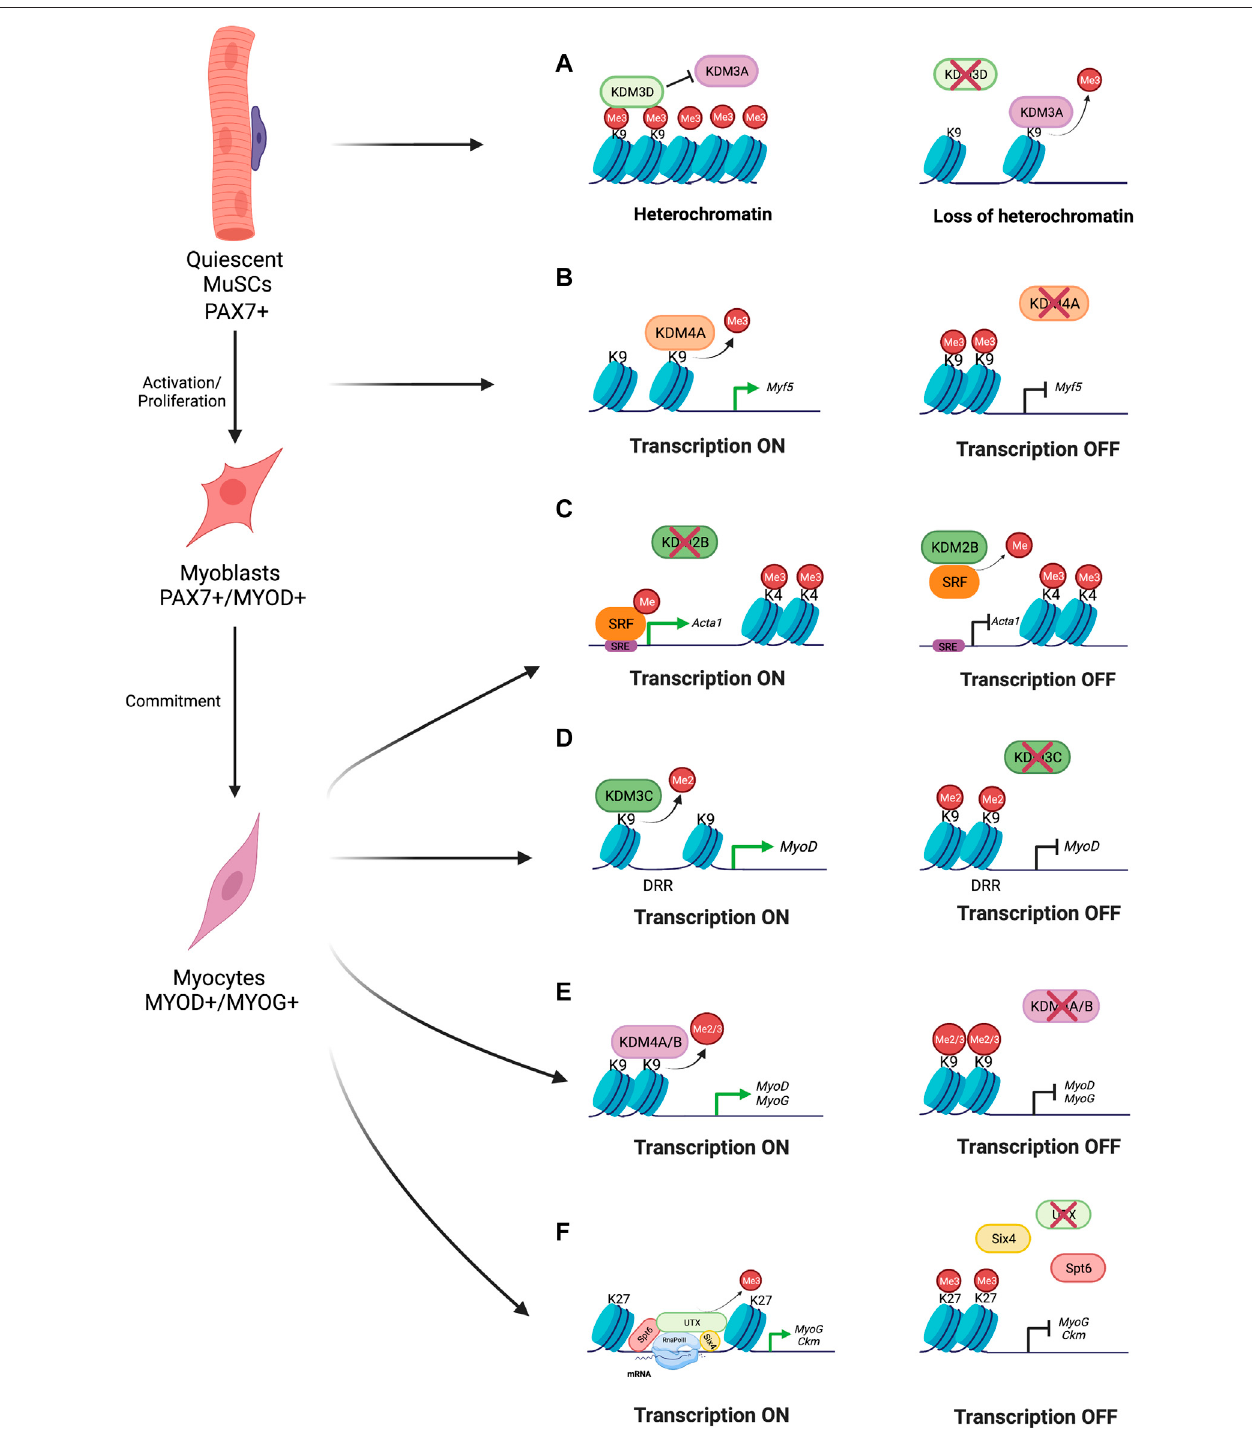
FIGURE 2 | Jumonji C-domain Demethylases Role during Skeletal Muscle Regeneration. (A) In order to maintain MuSCs quiescence, KDM3D inhibits KDM3A demethylase activity guarantying heterochromatin integrity. In absence of KDM3D, KDM3A demethylases H3K9me3 resulting in loss of heterochromatin content (Liu et al., 2021). (B) Upon MuSCs activation and proliferation, KDM4A is enriched on Myf5 promoter in proliferating myoblasts, where it removes H3K9me3 histone mark allowing thetranscriptionofMyf5 andpromotingcellproliferation.Conversely,KDM4Aablation results inH3K9me3accumulationrepressingthetranscription(Zhu etal.,2021). (C) KDM2BactsonActa1promoterdemethylatingserumresponsefactor(SRF)andpreventingitsbindingatserumregulatoryelements(SRE),thusleading to skeletal muscle differentiation impairment. On the contrary, KDM2B absence allows SFR to bind SRE thus resulting in Acta one transcription (Kwon et al., 2021). (D)